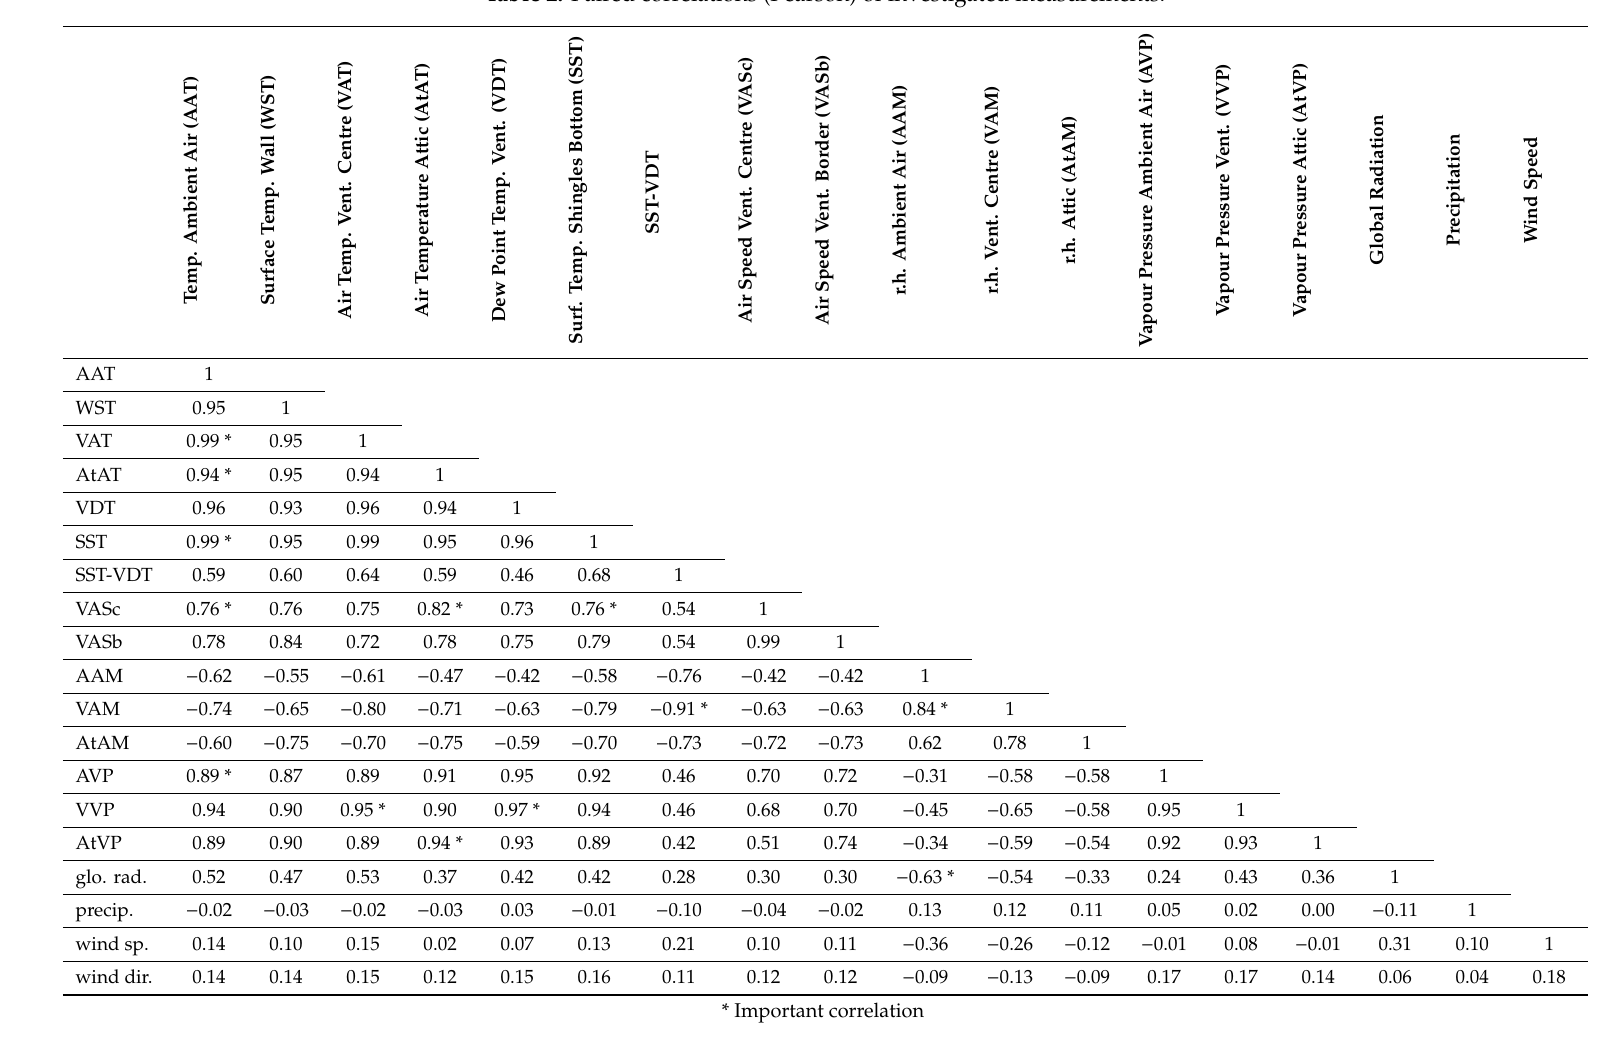
Table 2. Paired correlations (Pearson) of investigated